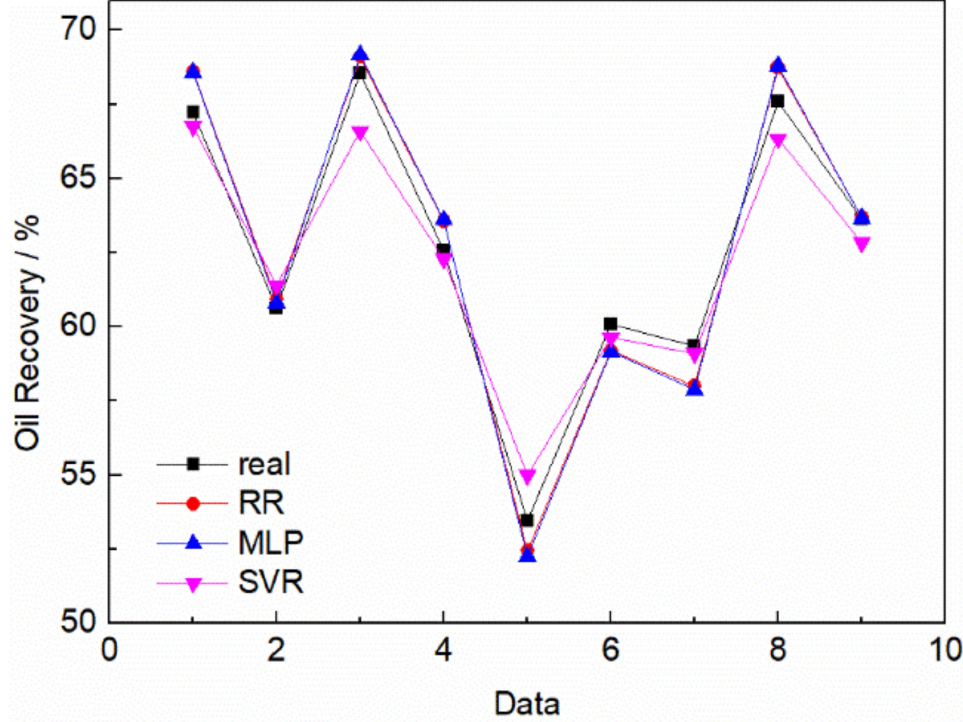
Figure 3. Comparison between prediction results of different machine learning algorithms and real experimental results. (‘real’ represents the experimental data, RR is the oil removal rate predicted by ridge regression algorithm, MLP is the oil removal rate predicted by multi-layer perceptron and SVR is the rate predicted by support vector regression algorithm